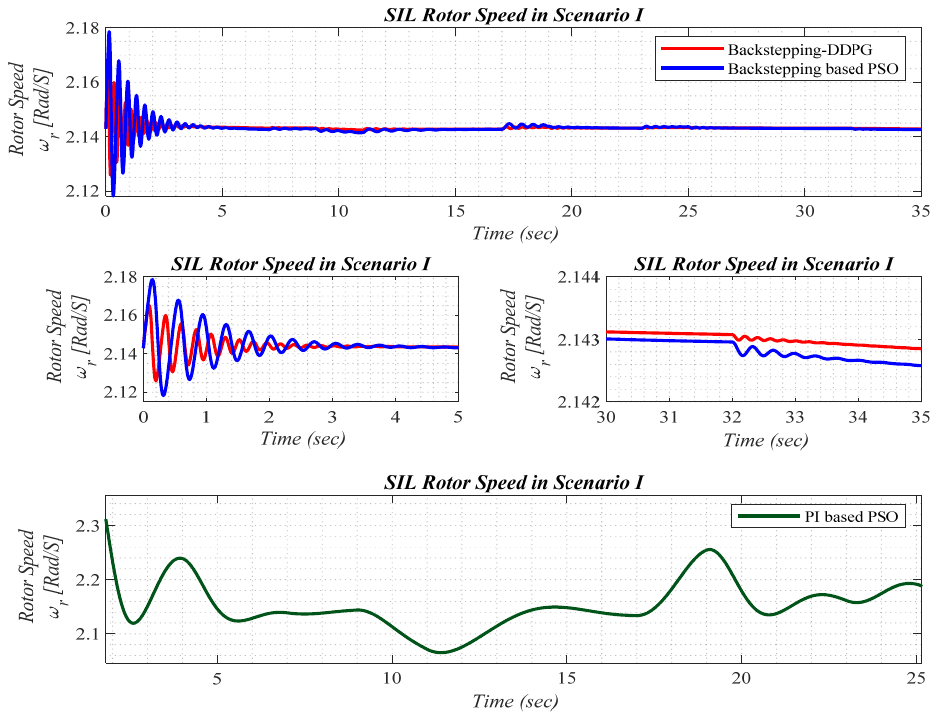
Figure 9. SIL output comparative results of backstepping controller based DDPG, backstepping controller based PSO and PI controller based PSO according to Scenario I.